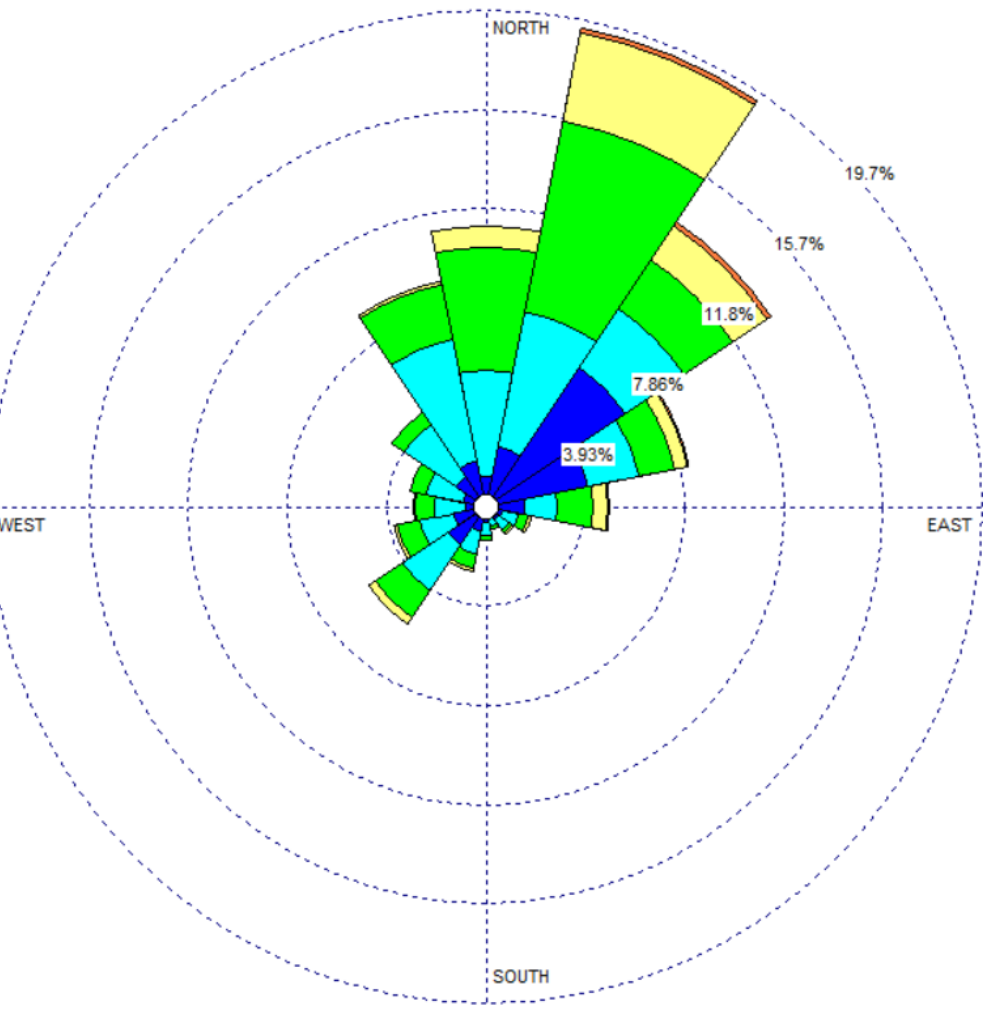
Figure A2. Wind Rose diagram of the study area. Table A2 . Modelled and Measured dust fall, highest monthly dust deposition at all receptors.